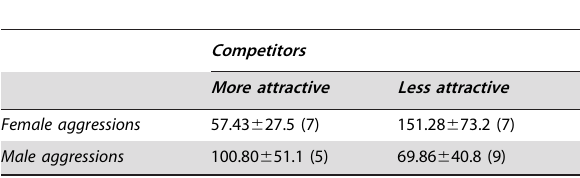
Table 3. Mean ( 6 SE) female and male aggressions/h towards a potential competitor (unpaired bird) that was either more or less attractive than